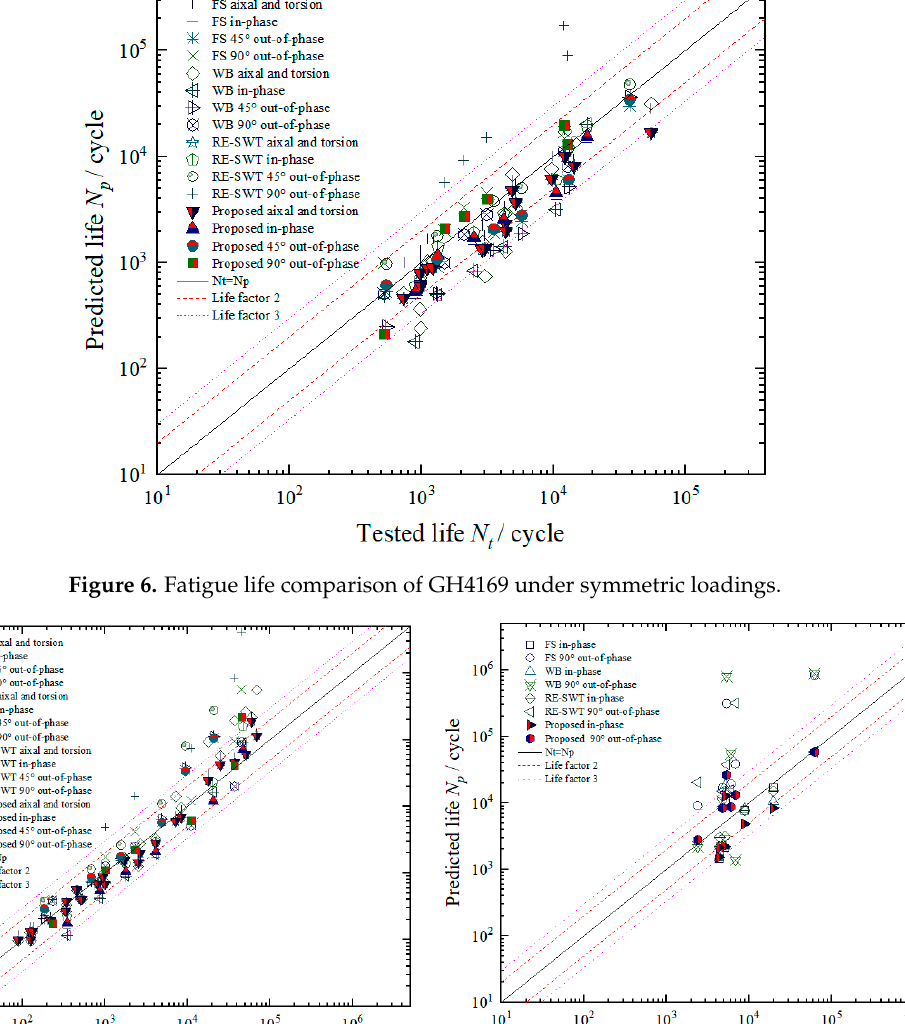
Figure 7. Fatigue life comparison of TC4 under symmetric and asymmetric loadings, ( a ) TC4 under symmetric loading; ( b ) TC4 under asymmetric loadings.